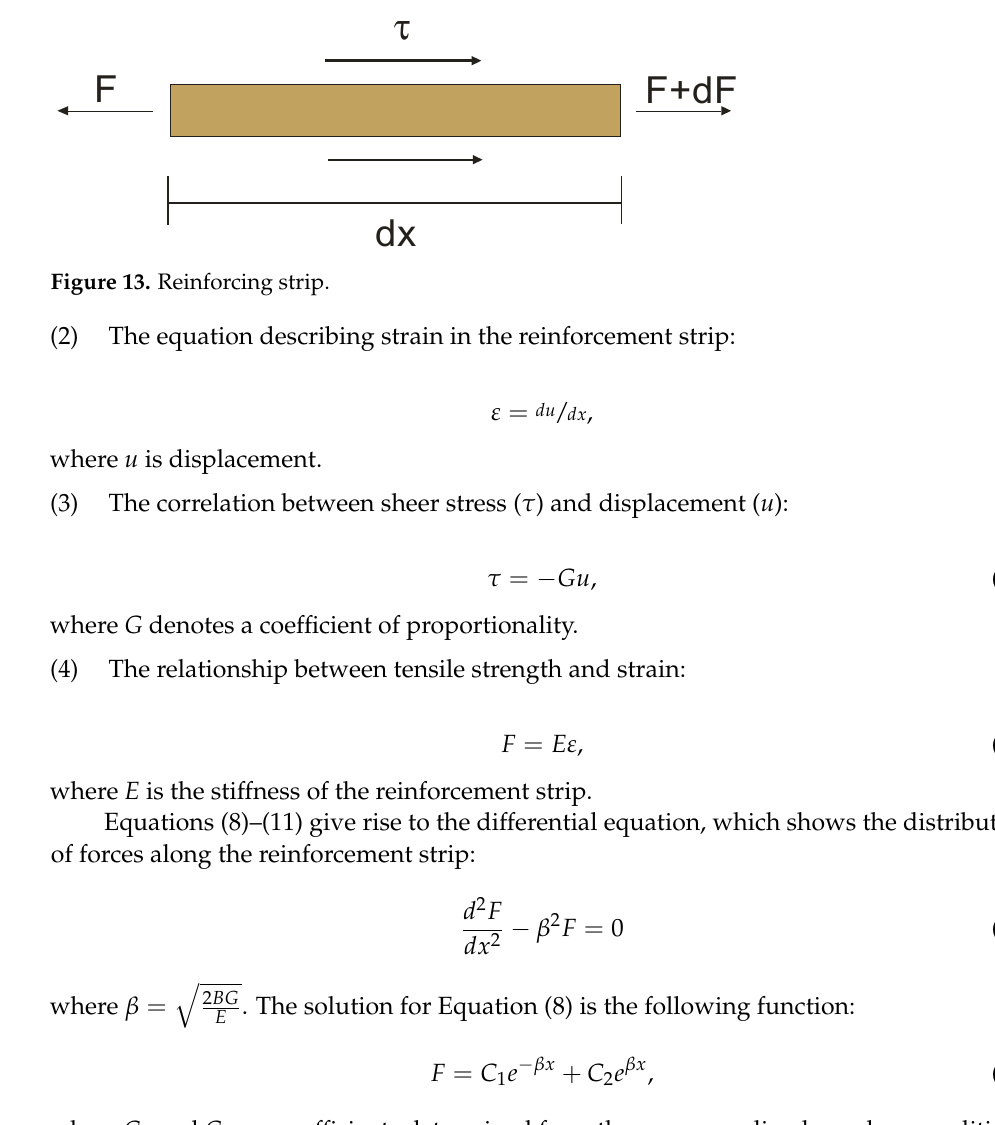
Table 5. Calculated ( u T ) and experimental ( u E ) displacement of the facing at subsequent load levels. Dist. from